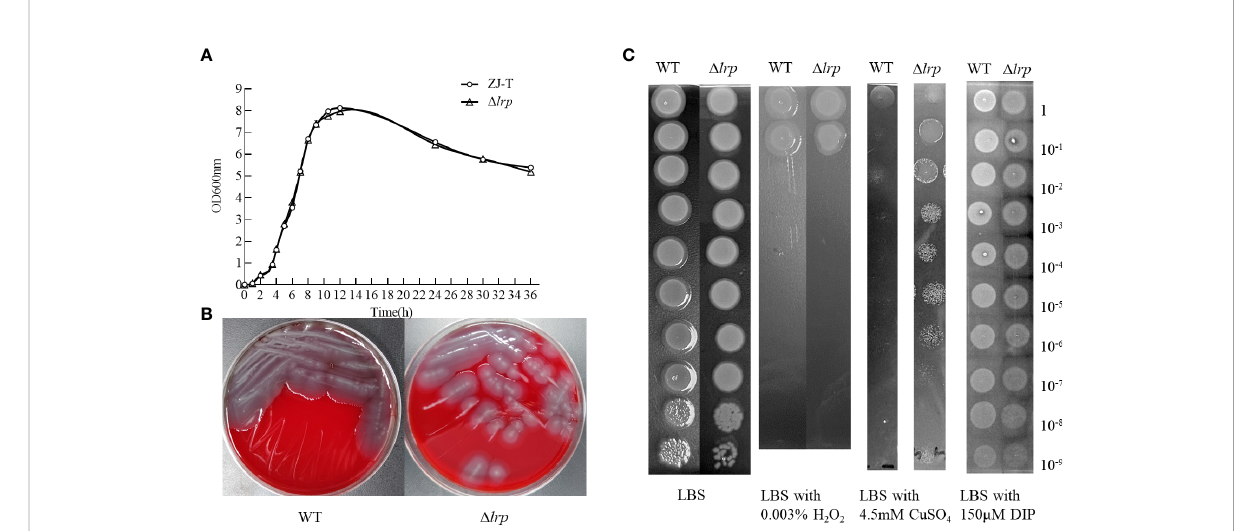
FIGURE 3 Growth, hemolysis, iron uptake capacity, copper ion and H 2 O 2 tolerance of the WT and D lrp strains. The growth curve of WT and (A) , and the hemolytic activity on sheep blood agar plate (B) , as well as their sensitivity of them to H 2 O 2 , CuSO 4 , and DIP on the LBS agar plate (C)